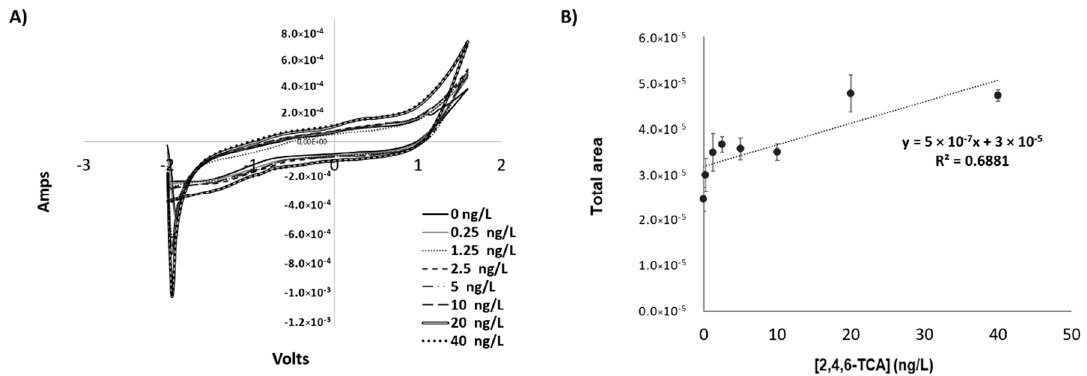
Figure 7. Cyclic voltammograms for MeOH/H 2 O mixtures (1:1 ( v / v ) with 0.1 M of TBAP) without (0 ng/L, black line) and with 2,4,6-TCA addition (0.25 to 40 ng/L) ( A ); Schematic representation of the calibration curve obtained for different 2,4,6-TCA concentrations in MeOH/H 2 O mixtures (1:1 ( v / v ) with 0.1 M of TBAP) ( B ).